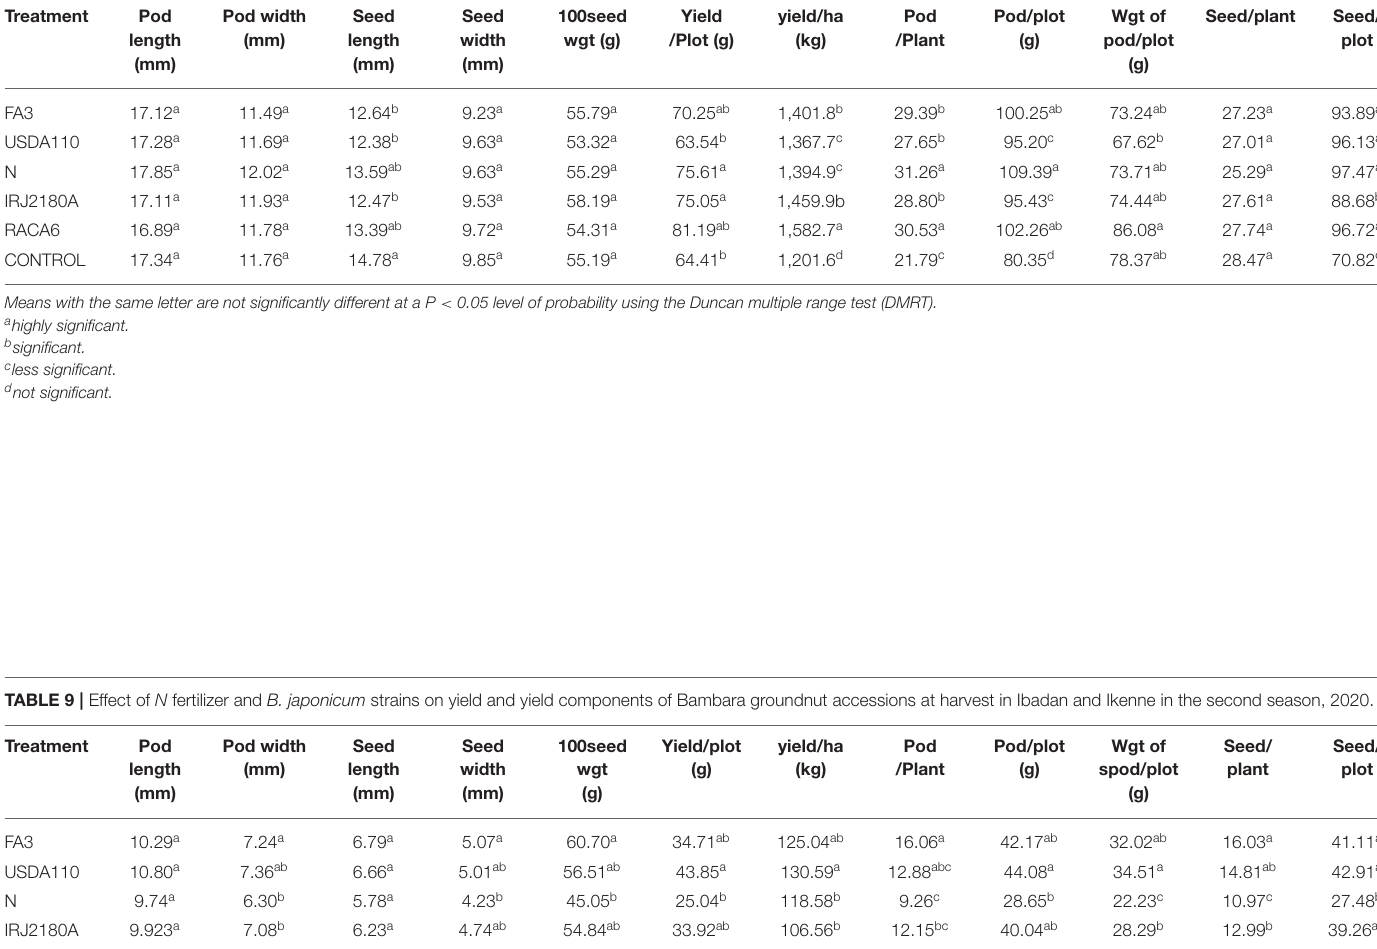
TABLE 8 | Effect of N fertilizer and B. japonicum strains on yield and yield components of Bambara groundnut accessions at harvest in Ibadan and Ikenne in the first season, 2019. Treatment Pod length